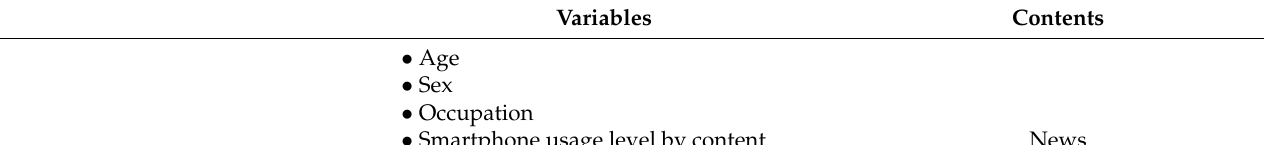
Table 1. Variables.